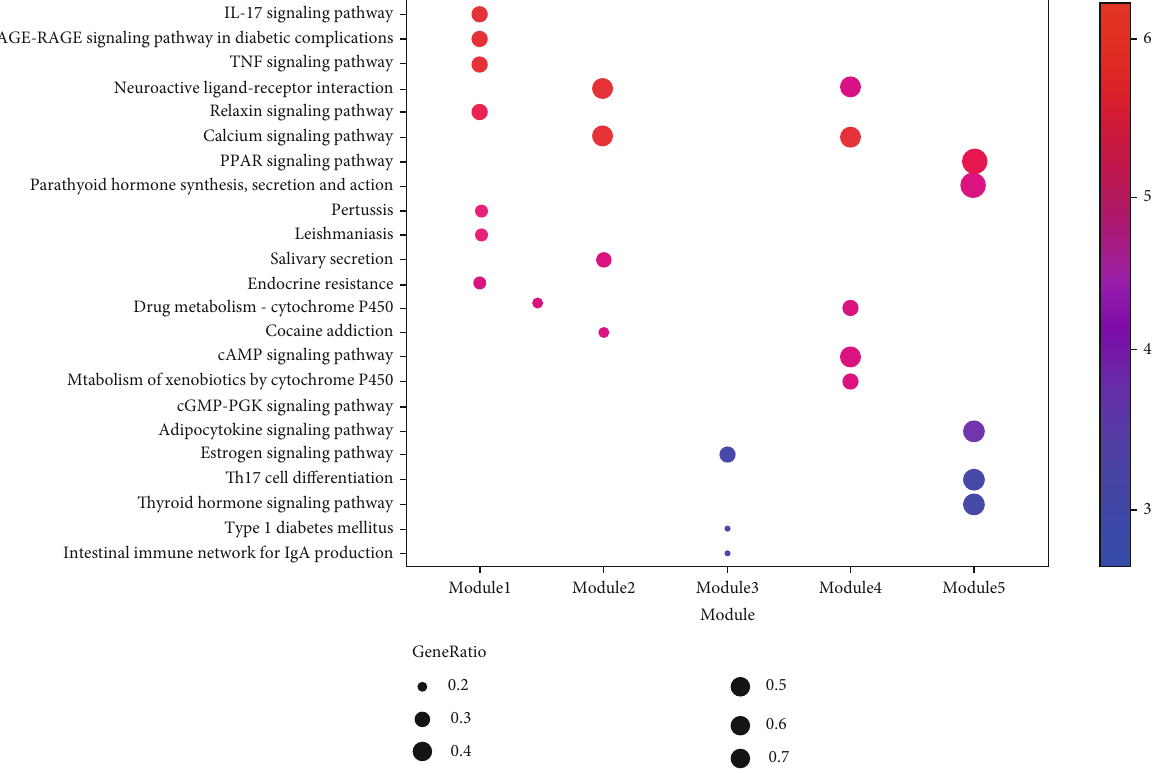
Figure 5: KEGG pathway analysis of 5 clusters. The color of nodes was described in a gradient from blue to red according to the descending order of the P value. GeneRatio equaled to gene count enriched in pathway/total gene count enriched in the